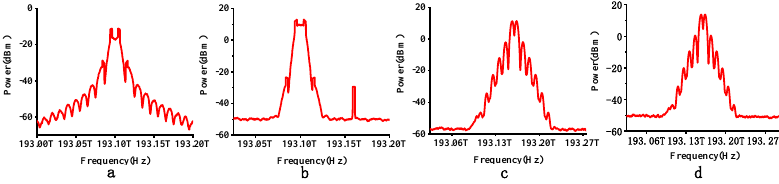
Fig. 2. Optical spectrums of the downlink 67% duty cycle RZ-4PAM and AMI uplink signals before and after